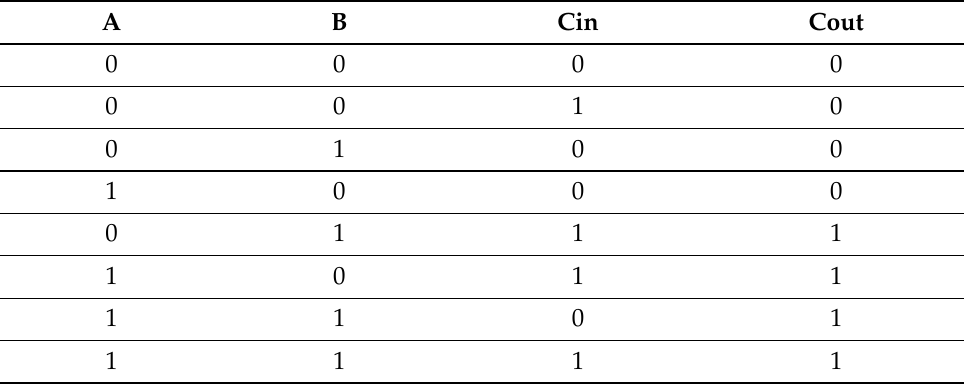
Table 4. Truth table of the majority